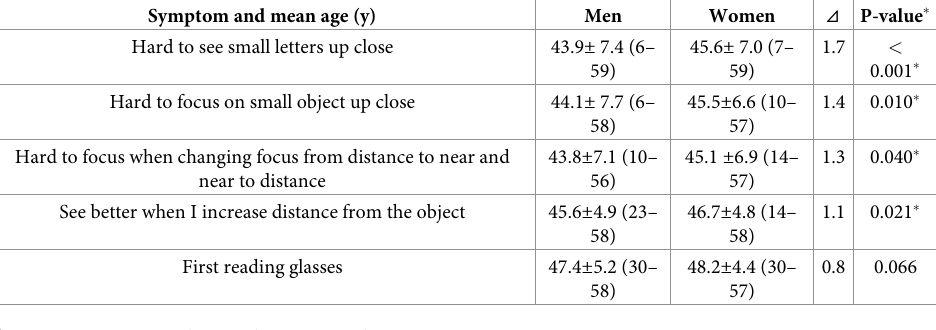
Table 2. Age of first awareness of difficulty focusing and first reading